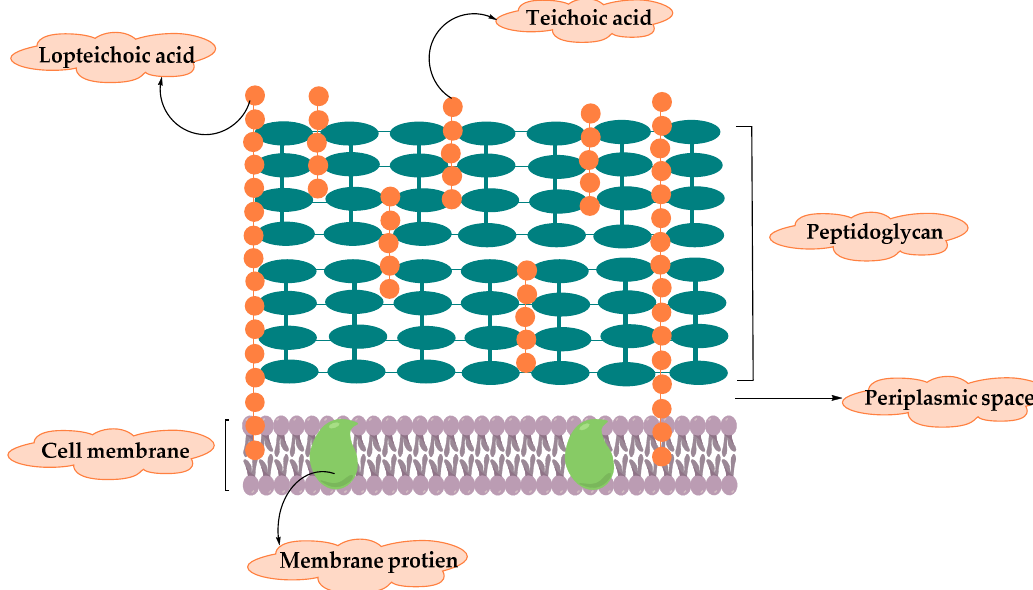
Figure 1. Diagram illustrating the cell wall structure of Gram-positive bacteria.